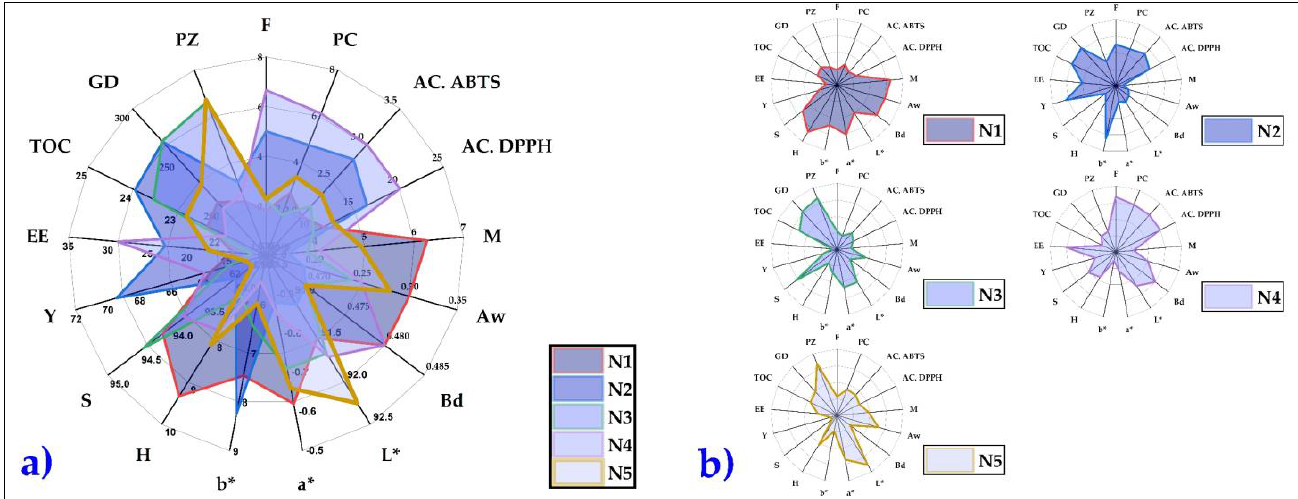
Figure 11. Radar plot of all nanoencapsulated properties (N1, N2, N3, N4, and N5); ( a ) all nanoen- capsulates superimposed on top of each other and ( b ) all independent nanoencapsulates.